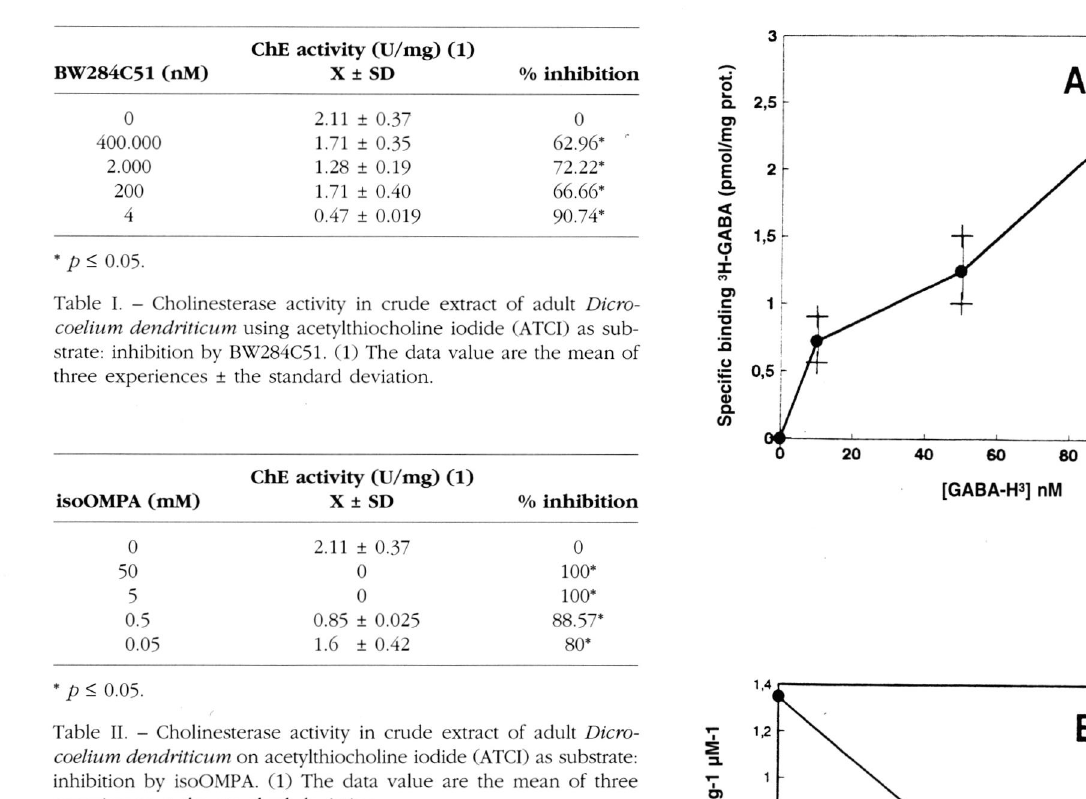
Table II. - Cholinesterase activity in crude extract of adult Dicro coelium dendriticum on acetylthiocholine iodide (ATCI) as substrate: inhibition by isoOMPA. (1) The data value are the mean of three experiences ± the standard deviation.